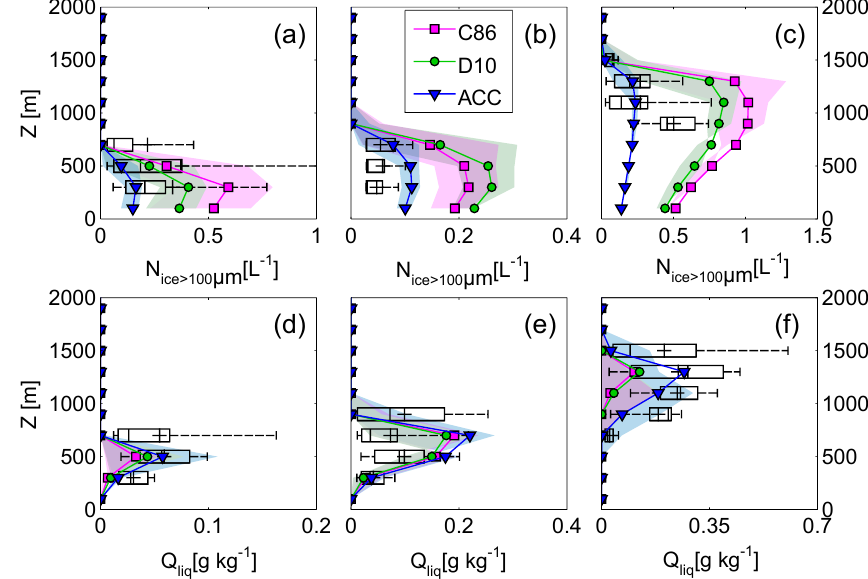
Figure 7. Observed N ice > 100µm and Q liq for the sea ice (column 1), MIZ (column 2), and ocean (column 3) cases. Observations are shown as black boxes, similar to Fig. 4. Mean modelled concentrations of ice and snow particles greater than 100µm, using the C86 (magenta), D10 (green), and ACC (blue) parameterisations, are overlaid. Model time steps of 21, 17, and 7h are used for the sea ice, MIZ, and ocean cases respectively, as these time steps offer the best comparison with the observations. Shading (in pink, green, or blue for C86, D10, and ACC respectively) indicates variability in the model parameters from ± 3h in cases 1 and 2, and ± 4h in case 3, where a larger interval is implemented in the latter case as the chosen parameters showed little variability over the shorter time step. In panel (f) , the variability illustrated is always less than the mean modelled profile shown using each parameterisation as the Q liq is at its greatest at the chosen time step. Observed N ice > 100µm data from noted shattering event (Young et al., 2016a) are excluded in panel c , so that only primary contributions of ice are